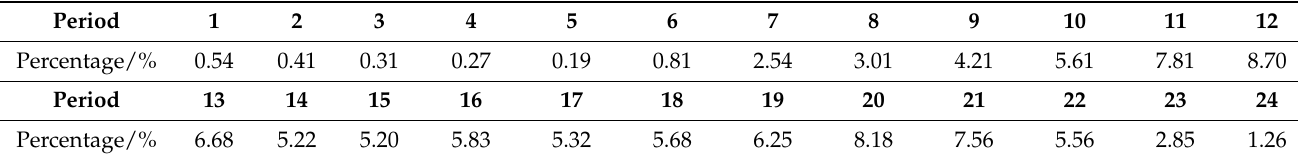
Table A2. Percentage of HFCV mileage in each period to daily